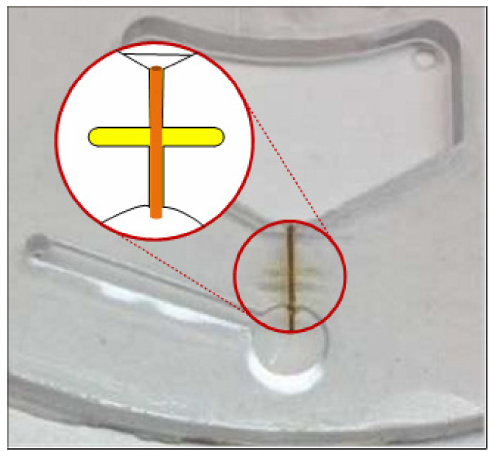
Figure 4. Photomicrograph of a sealed capillary valve embedded inside an assembled